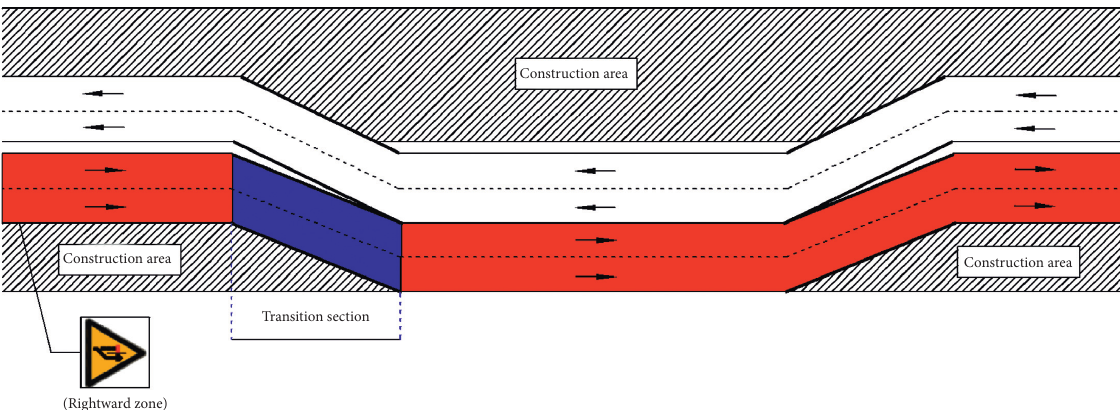
Figure 1: Work zone of the rightward